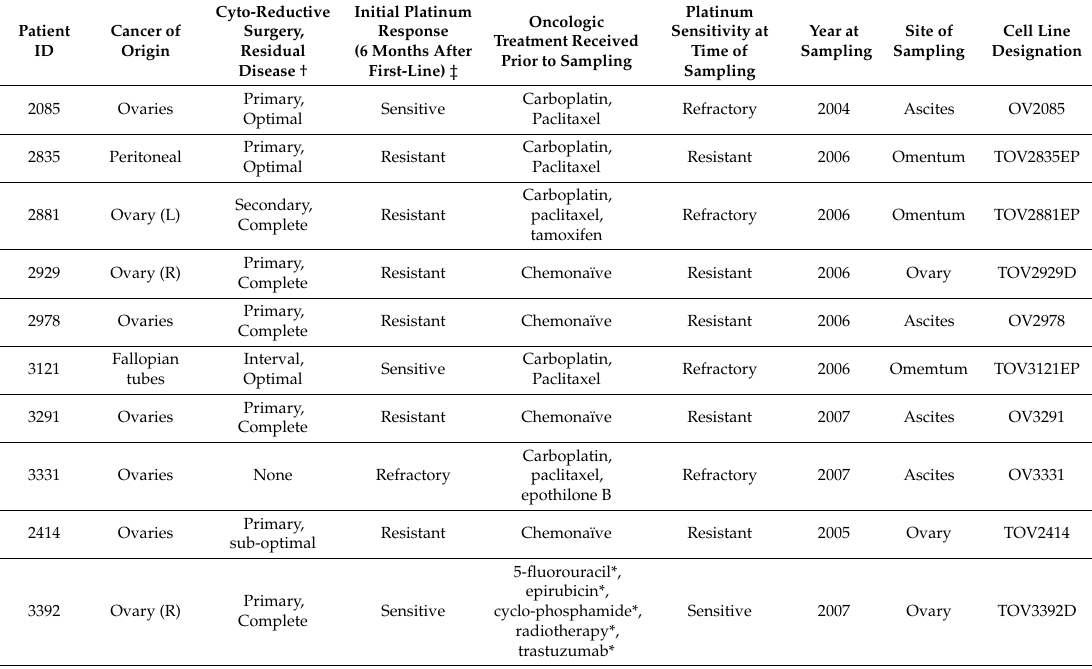
Table 2. Treatment and sampling information for samples from which cell lines were